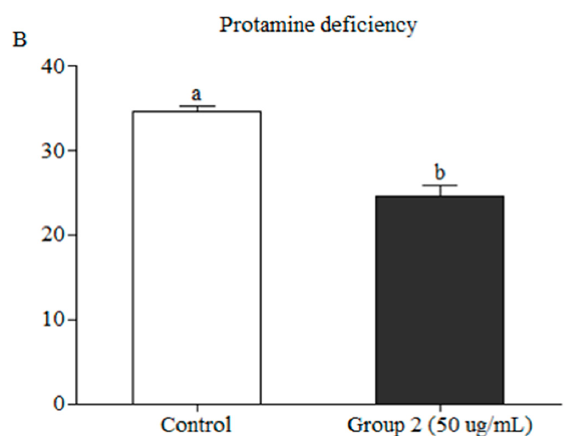
Figure 5. Quantification of Chromomycin A3 in exosome treated and untreated sperm ( p < 0.05).